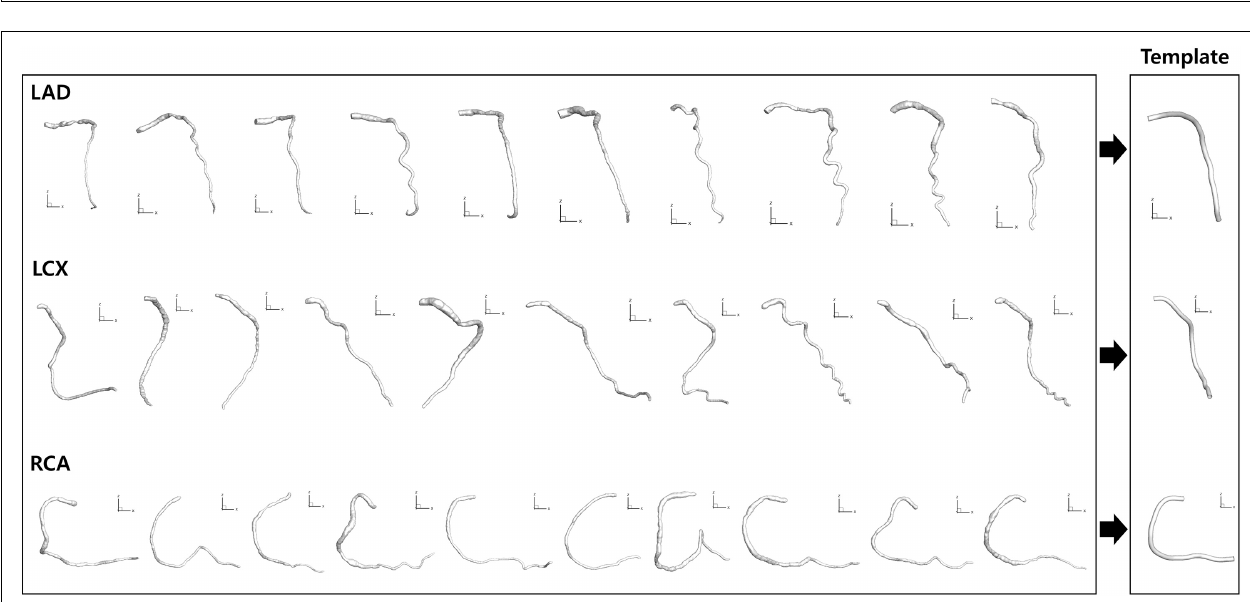
FIGURE 2 | The number of images used for the deep learning network. The cases were divided into the training, validation, and test cases randomly with the ratio of 6.3:2.7:1, which resulted in the number of images shown in the bottom boxes. Each case had up to 8 images full of contrast medium in the vessel.